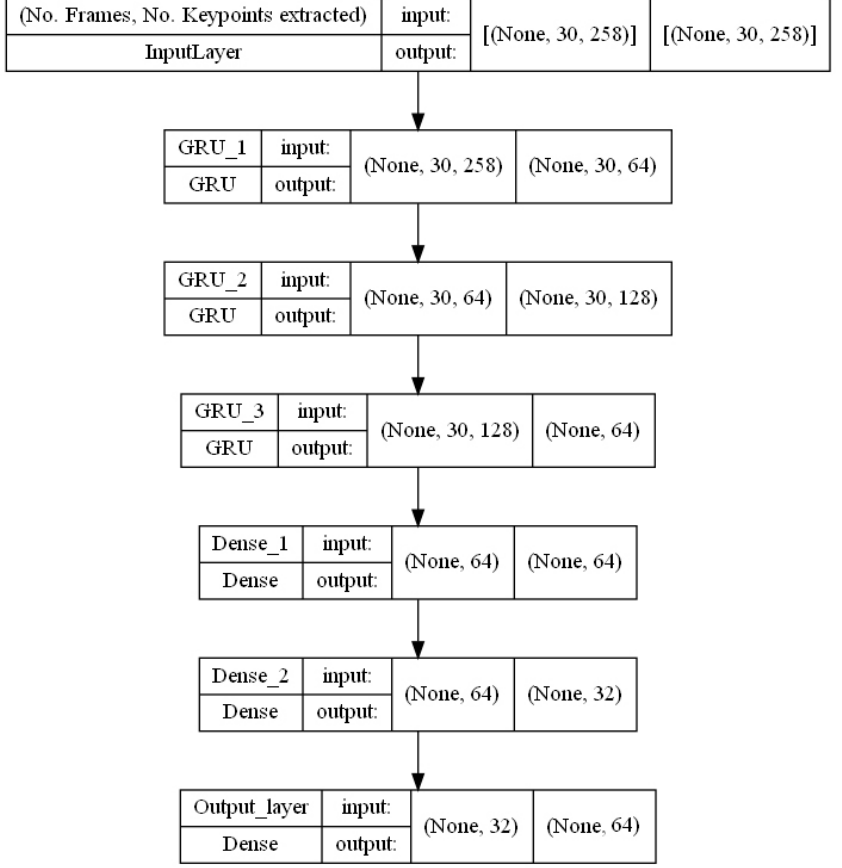
Figure 10. GRU Model